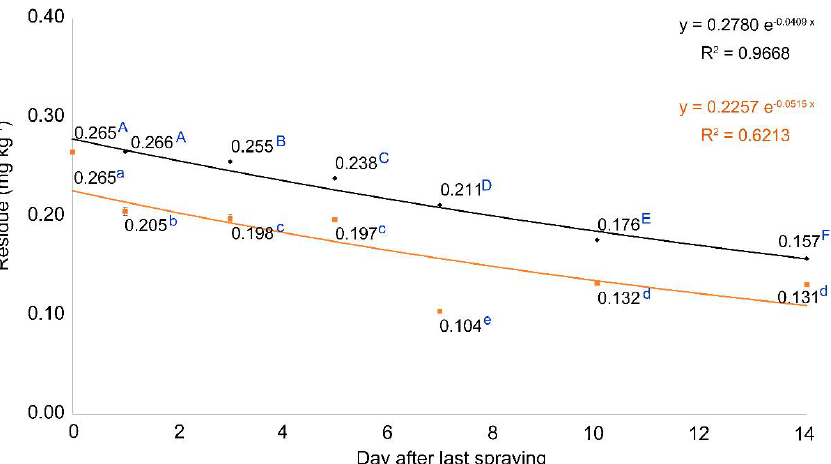
Figure 4 . Dissipation of picarbutrazox residue with standard deviation (n = 3) over time in Chinese cabbage, sprayed using a multicopter in plot 2. Black and yellow represent the residue in Chinese cabbage excluding and only considering the growth dilution effect, respectively. Different letters in the dissipation curve indicate significant differences at p < 0.05 by least significant deviation.